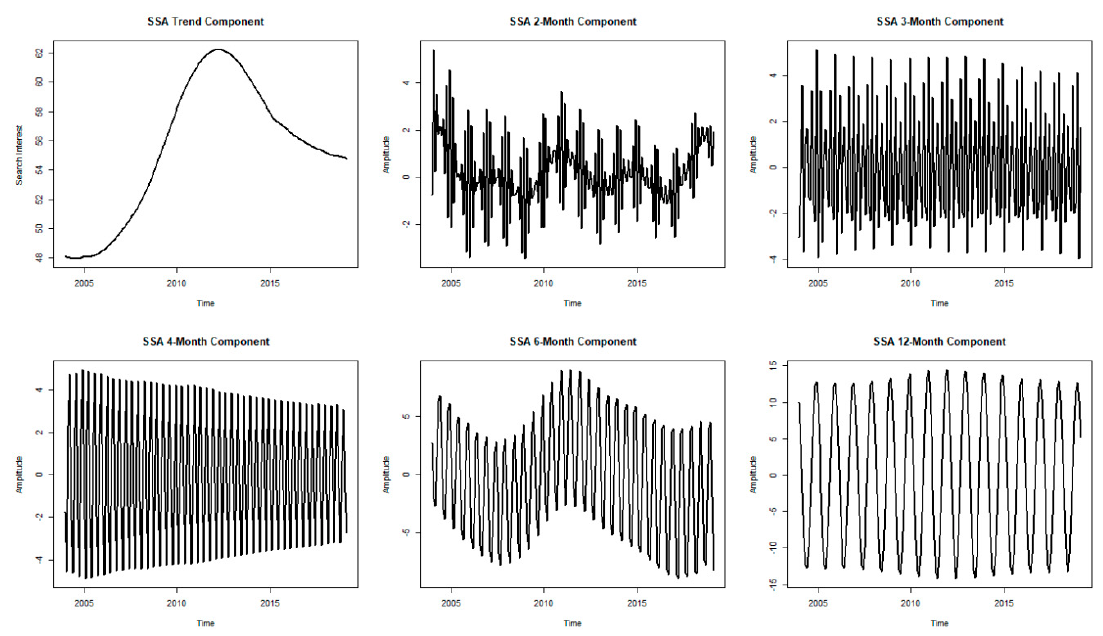
Figure 11. Singular spectrum analysis (SSA) signal extractions for “Burberry” fashion consumer Google Trends.